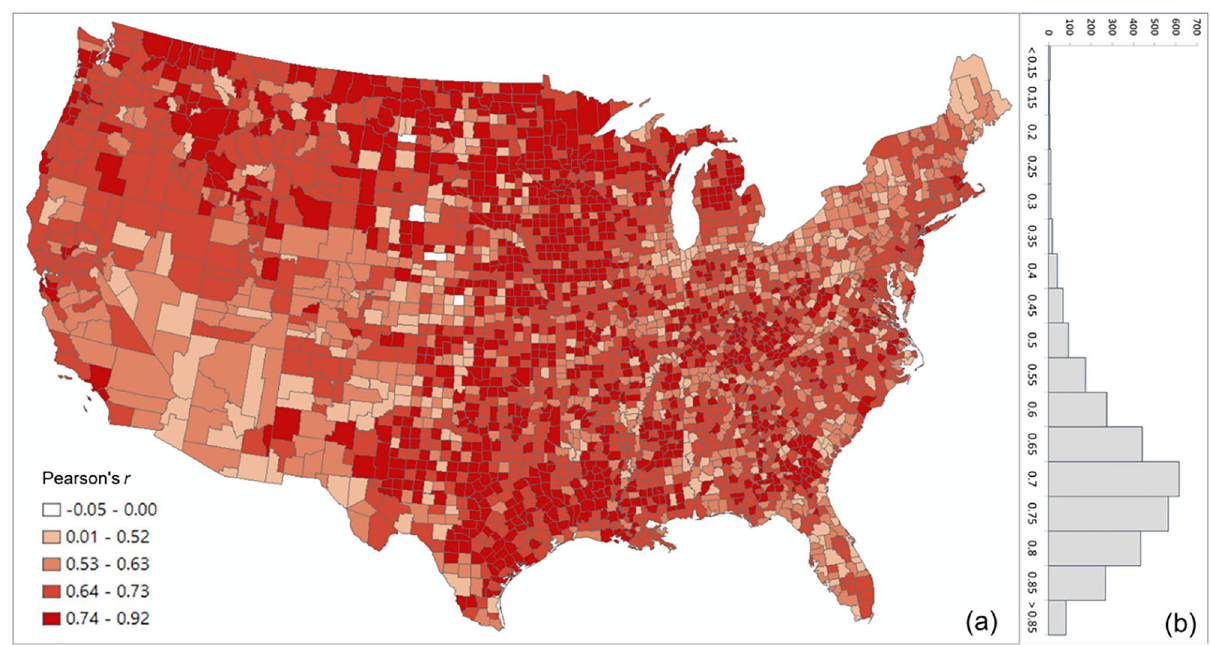
Figure 6. Distribution of the Pearson’s r between log PCI and log Facebook SCI for all counties ( a ) Spatial distribution; ( b ) histogram. The map was generated using ArcMap version 10.7.1.